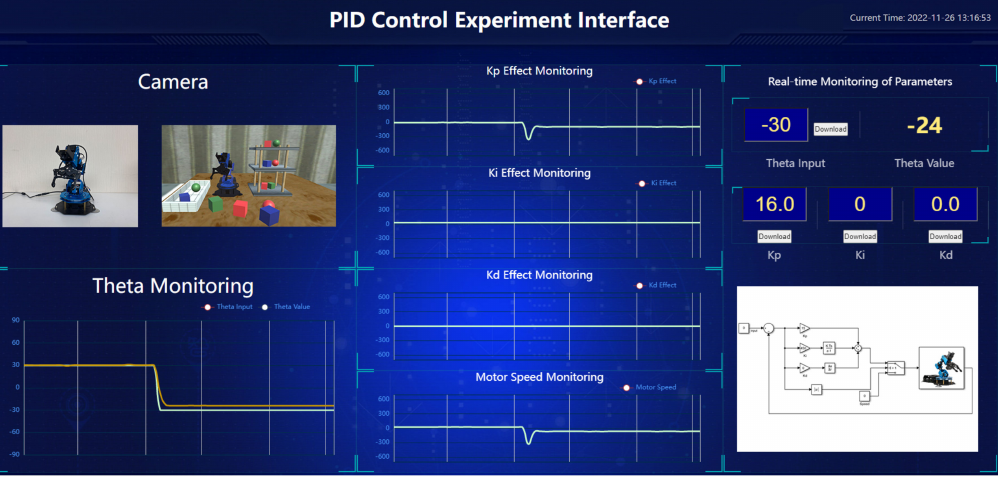
Figure 14. Experimental result with P